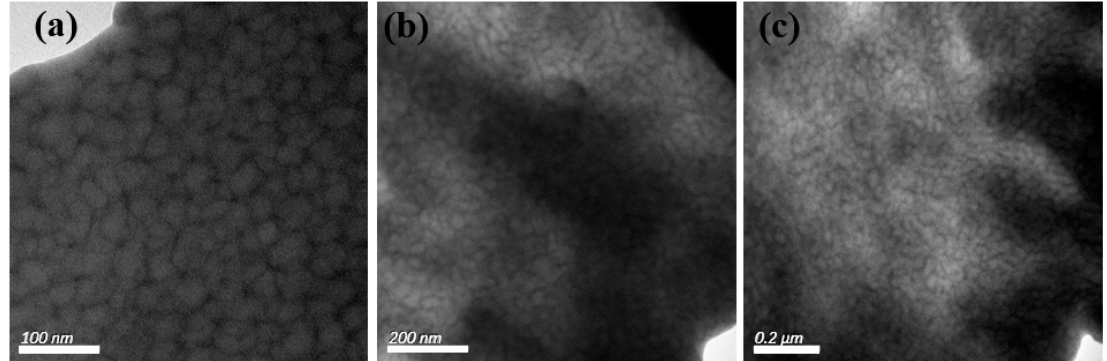
Figure 7. TEM image of S-SEBS polymer with various amounts of TA. ( a ) 1 wt.%; ( b ) 10 wt.%; ( c ) 20 wt.%.